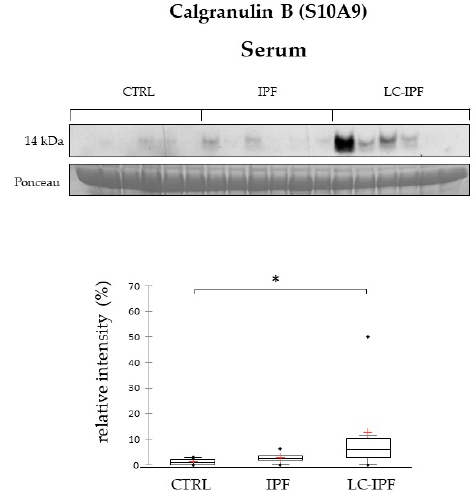
Figure 7. Western blot analysis of calgranulin B in serum samples. Statistical analysis was performed